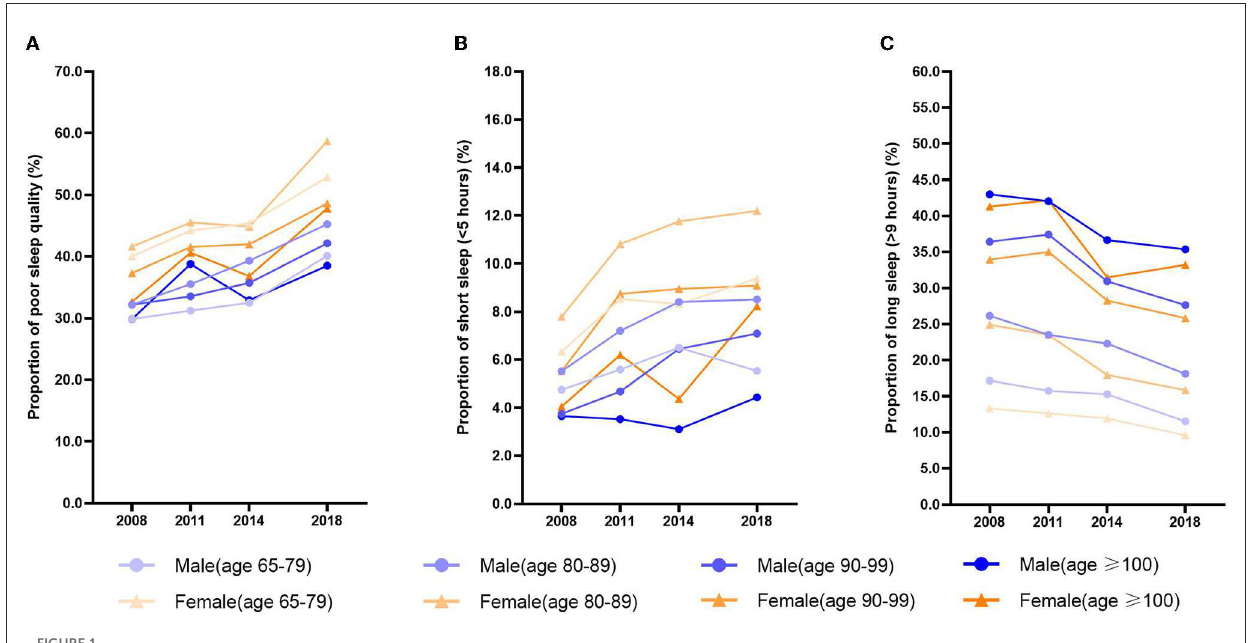
FIGURE1 Trends of sleep quality and sleep duration in different gender and age